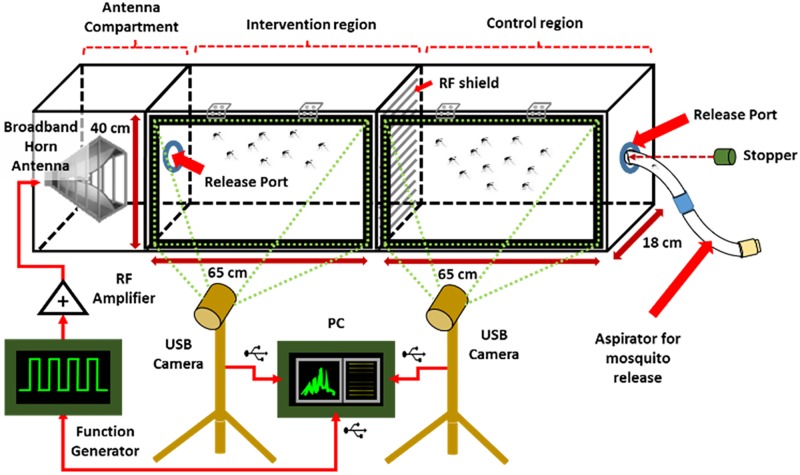
Evaluation chamber.